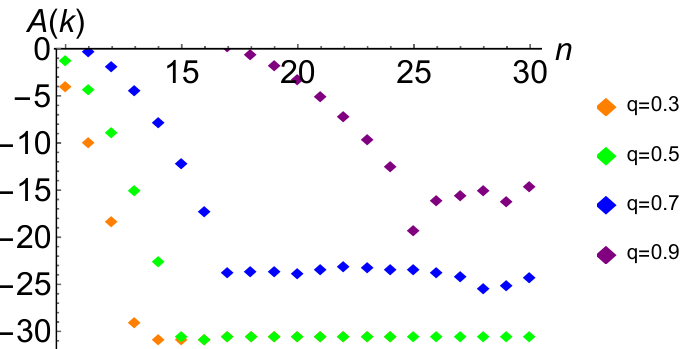
Figure 3: The logarithm of the difference between the sum over the CSMM SFF for N “ 10 and the CUE ( q Ñ 0) SFF, plotted for various values of q . We see that the difference is very small and decreases quite rapidly with k but, conversely, increases with q .